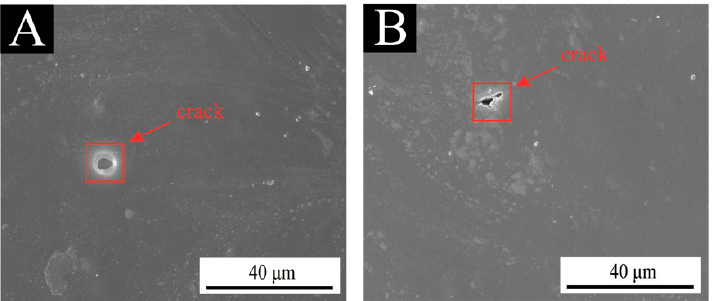
Figure 14. SEM images of coating without and with microcapsules after aging in UV weather resistance test: ( A ) without microcapsules, ( B ) with 6.0% microcapsules.